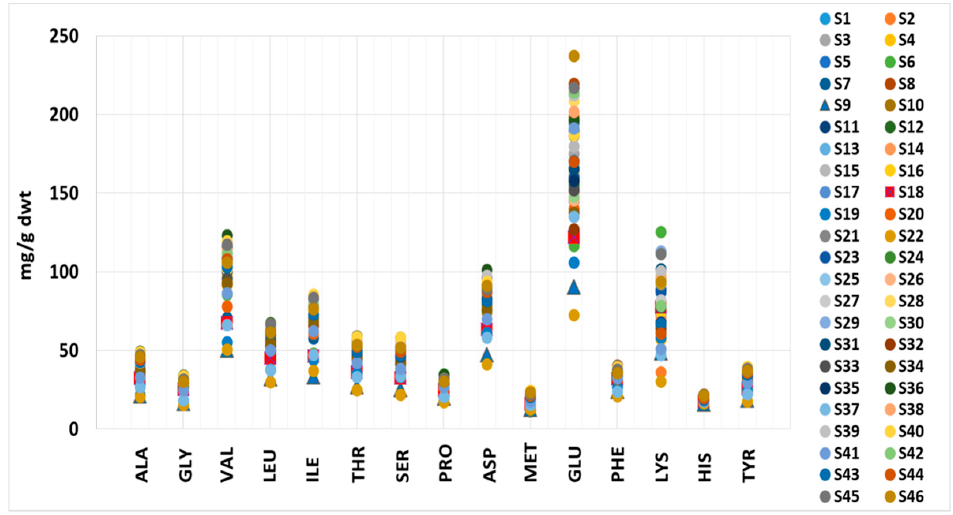
Figure 1. The amino acid content range in Spirulina supplements.